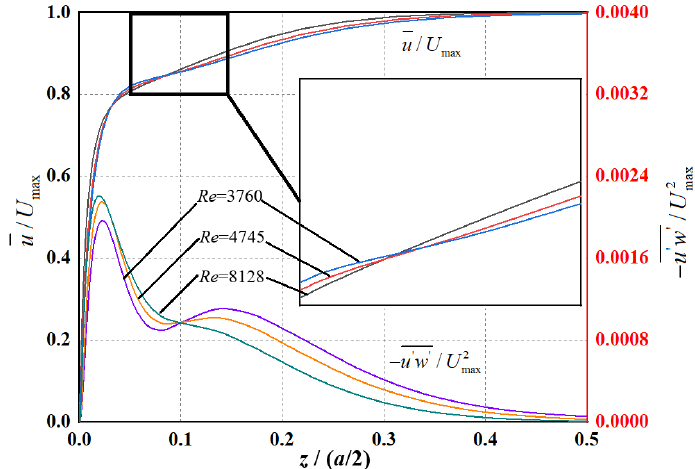
Figure 15. Velocity and Reynolds shear stress component distribution on Z direction centerline.